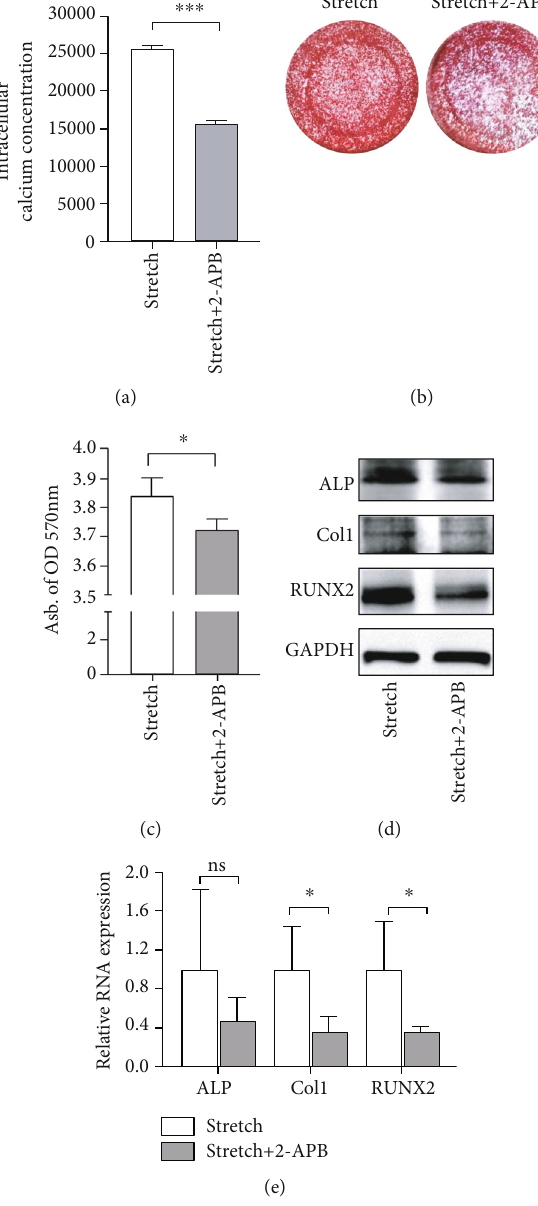
Figure 4: Mechanical stretching regulates JBMMSC osteogenesis via IP R-mediated intracellular calcium increases. (a) Intracellular calcium 3 concentrations visualized at mean fl uorescence intensity decreased after 2-APB treatment, compared with the stretch group. ∗∗∗ P < 0 : 005 ; n = 3 . (b) JBMMSCs treated with 2-APB showed fewer mineralized nodules, here stained using alizarin red. (c) The abundance of mineralized nodules in the stretch group was higher than that in the stretch+2-APB group. ∗ P < 0 : 05 ; n = 3 . (d) Western blot analysis indicated downregulation of ALP, RUNX2, and Col1 protein expression in JBMSCs after 2-APB and mechanical stretching treatment, compared with cells subjected only to mechanical stretching. β -Tubulin was used as an internal control; n = 3 . (e) RT-qPCR showed downregulation of ALP, RUNX2, and Col1 RNA expression in JBMSCs after 2-APB and mechanical stretching treatment, compared with cells subjected only to mechanical stretching. GAPDH was used as an internal control. ∗ P < 0 : 05 ; ns P > 0 : 05 ; n = 3